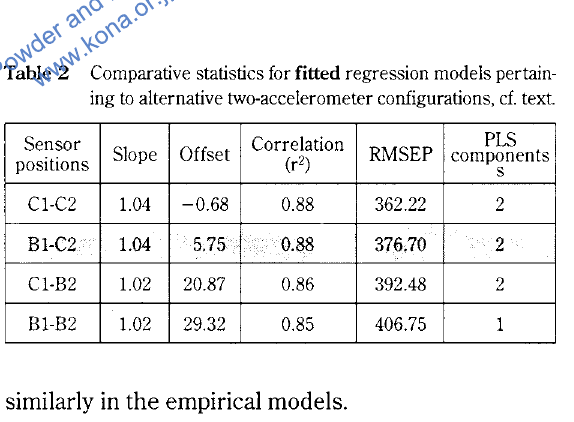
Table 2 Comparative statistics for fitted regression models pertain ing to alternative two-accelerometer configurations, cf. text. Sensor